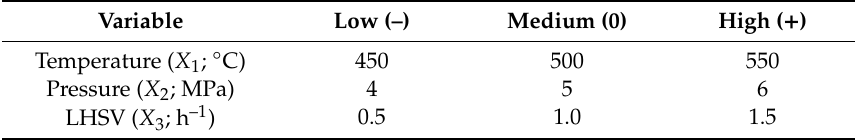
Table 1. The ranges of values of the investigated factors used for the experimental